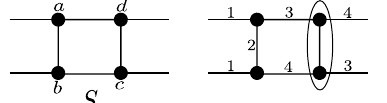
Fig. 4: An attempt to find a strong-edge-coloring of S